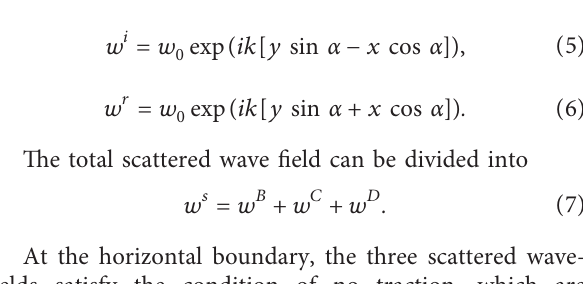
Figure 2: Surface displacement amplitude of degraded isosceles triangle